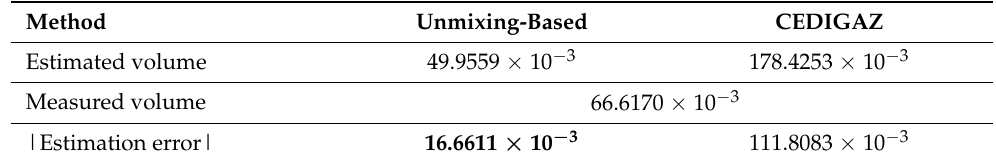
Table 4. Estimated annual 2020 flared gas volumes (in BCM) for the considered FIT-M8-101A-1U flare (the bold value represents the best estimation error).